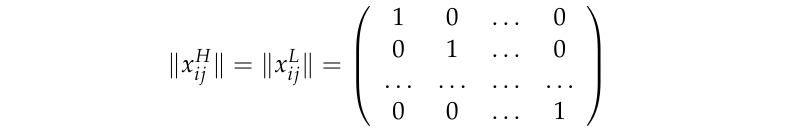
Figure 1. Membership functions of fuzzy sets High ( a ) and Low ( b ) . According to the theory of stochastic automata in random environments [39], the change of states of automata A L and A H is described by two functions of their transitions from state to state. When their input receives a “non-penalty” signal indicated by a variable